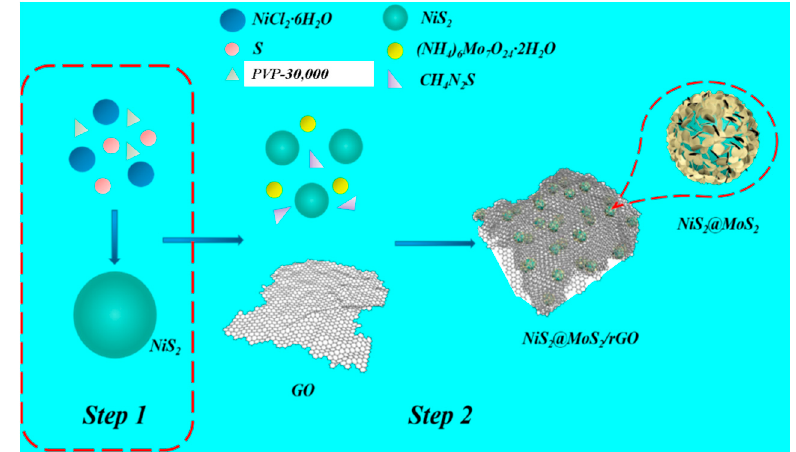
Figure 1. Schematic illustration of the formation process of the NiS2 nanospheres and NiS 2 @MoS 2 /rGO composites.